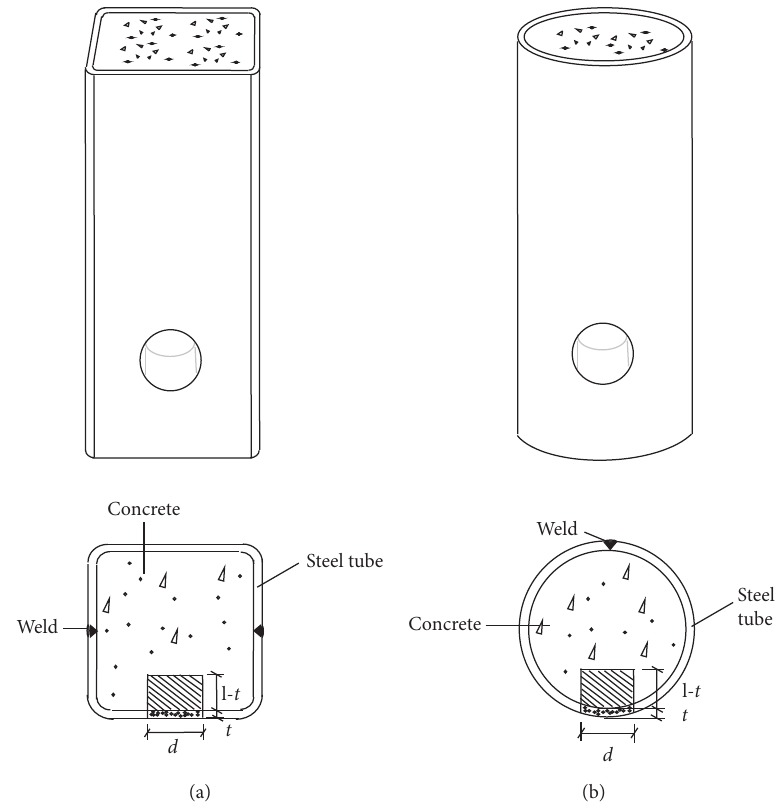
Figure 14: Sketch for the hole in the CFST columns with square section and circular section. (a) Square section. (b) Circular